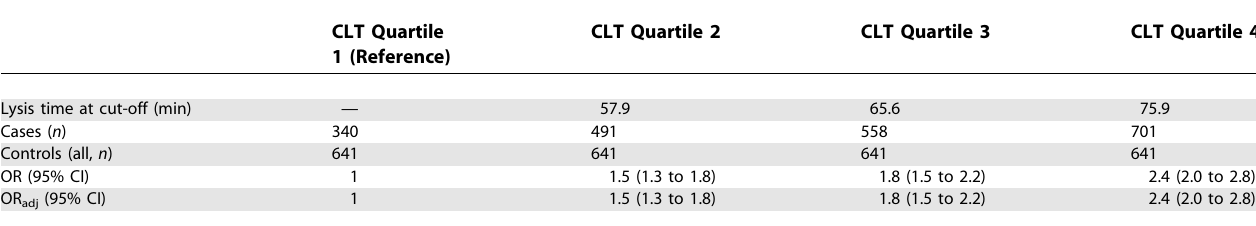
Table 1. Relative Risk of Venous Thrombosis According to Quartiles of Clot Lysis